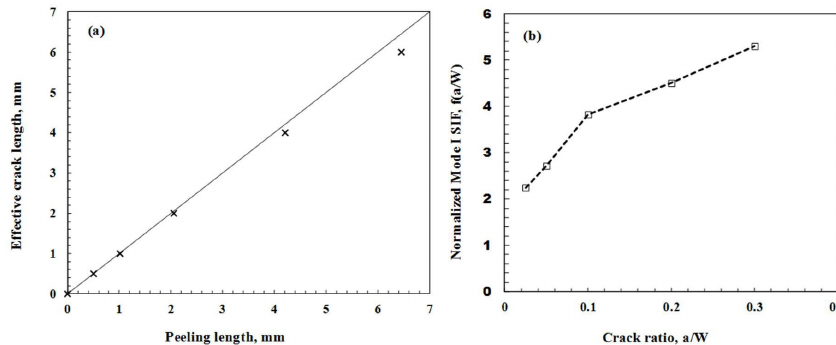
Figure 15. (a) Relation between effective crack length and peeling length, and (b) normalized mode I SIF.